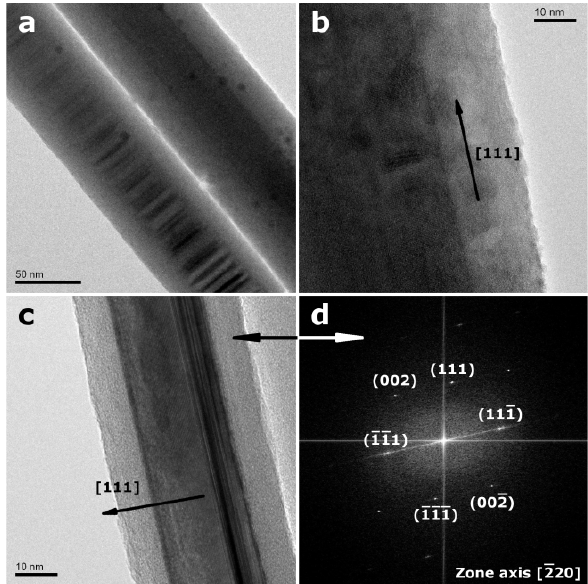
Figure 9. Representative TEM analyses of ZB nanowires grown from InP/Zn sources at 400 °C: ( a , b ) grown along [111]; ( c ) grown perpendicular to [111] and ( d ) Fast Fourier Transform of ( c